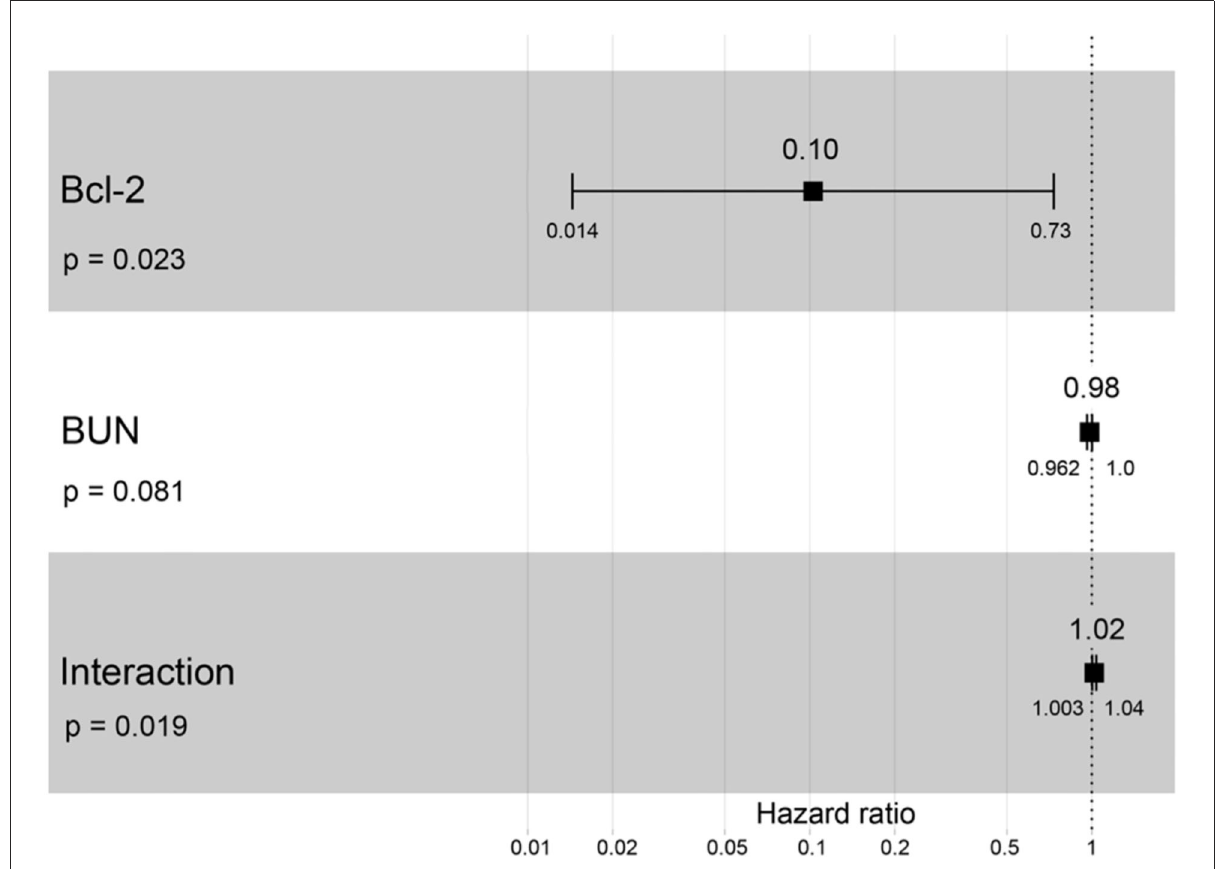
FIGURE9 Forest plot output for the interaction of Bcl-2 with BUN that is covariate with the CKD progression based on hazard ratios (HRs) via Cox regression analysis. Squares represent hazard ratios. Bars represent 95% confidence